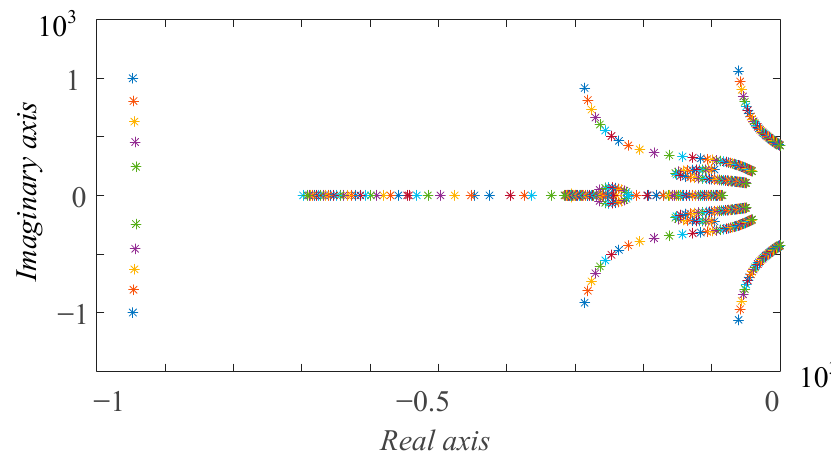
Figure 13. The root locus of the Jacobian matrix J 1 .